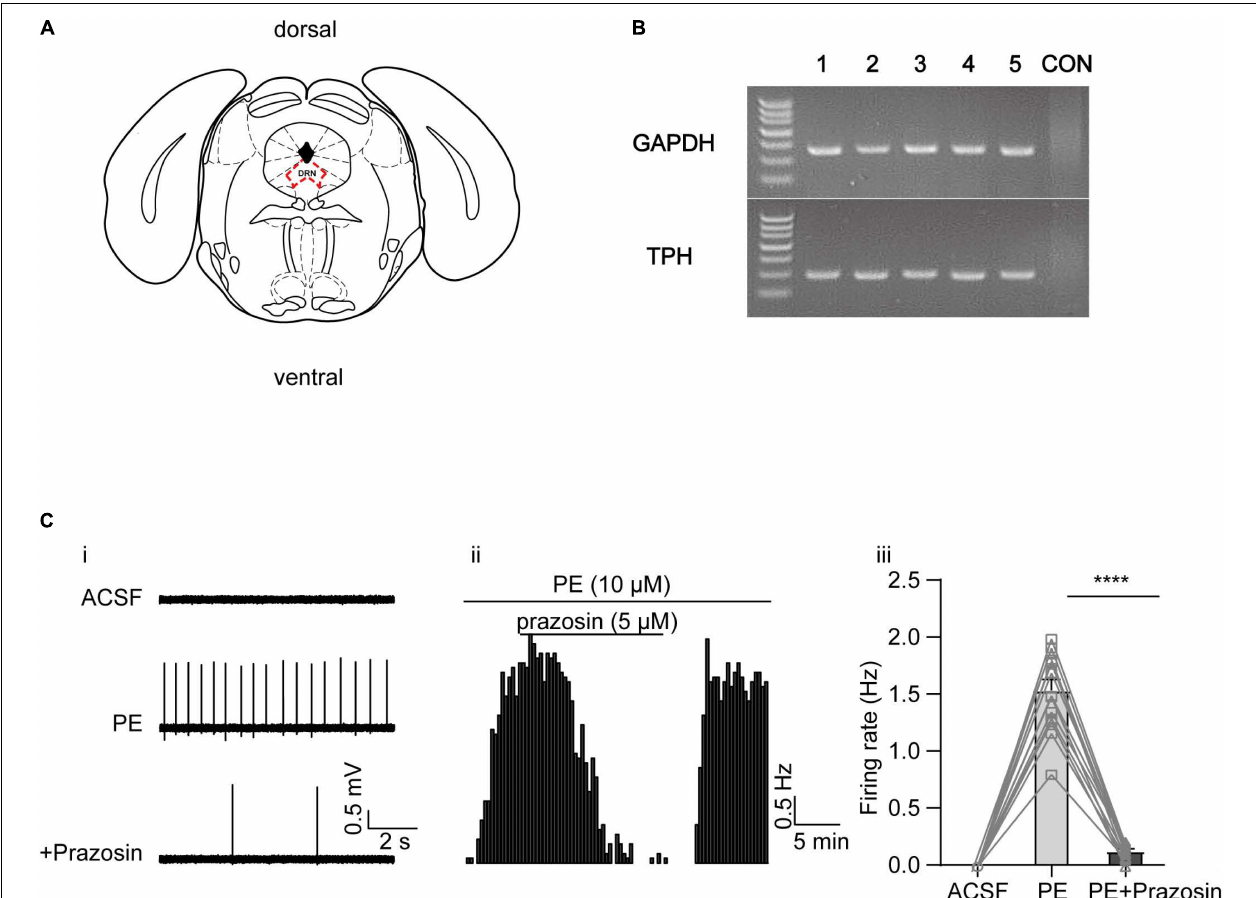
FIGURE 1 | Phenylephrine induces spontaneous firing in the DRN 5-HT neurons by activating α 1 adrenergic receptor. (A) Schematic illustration of the dorsal raphe nucleus (DRN) on a coronal plane. (B) Representative image of single-cell PCR products displayed on a gel, from five DRN neurons (lanes 1–5), and a negative control (“CON”) in which no DNA template from neurons was added. TPH, tryptophan hydroxylase, marker of 5-HT neurons. (C) PE induced the spontaneous firing activity in the DRN 5-HT neurons, which was inhibited by α 1 adrenergic receptor blocker prazosin. (i) Representative traces of action potential spikes recorded using “loose patch” under current-clamp configuration performed on a DRN 5-HT neuron; the effects of PE (10 µ M) and prazosin (5 µ M) are shown. (ii) Example time course of the spontaneous firing frequency in a 5-HT neuron, under the influence of PE and prazosin. (iii) Summarized effects of PE and prazosin on the spontaneous firing frequency (paired t -test, **** p < 0.0001, n =